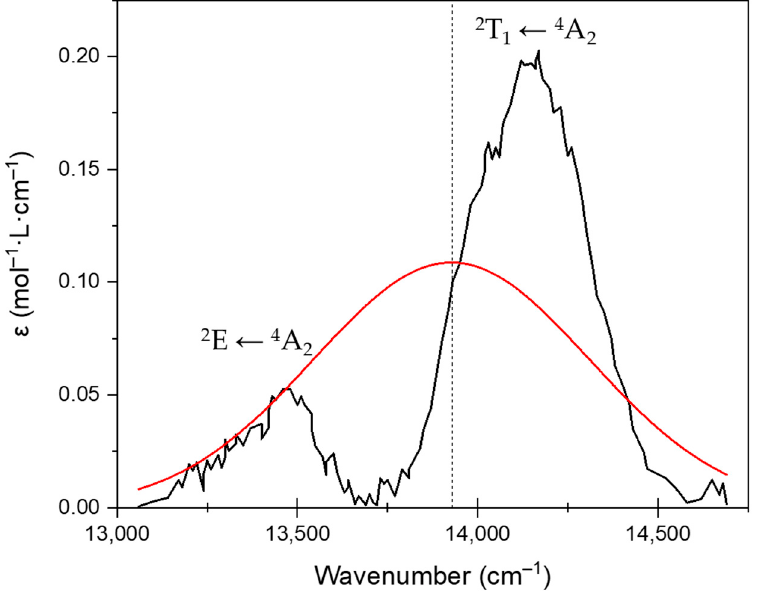
Figure 3. Absorption peaks of Cr(III) 2 E ← 4 A 2 and 2 T 1 ← 4 A 2 transitions (black lines) for the [CrErCr(bpb-bzimpy) 3 ] 9+ complex. The red curve is the envelope involving these two transitions. Adapted with permission from [55].